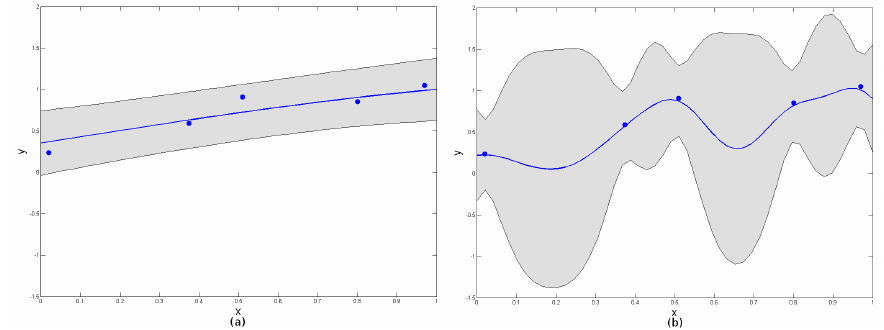
Figure 5. Gaussian processes fit with two length-scales: ( a ) 1.6 and ( b ) 0.08.